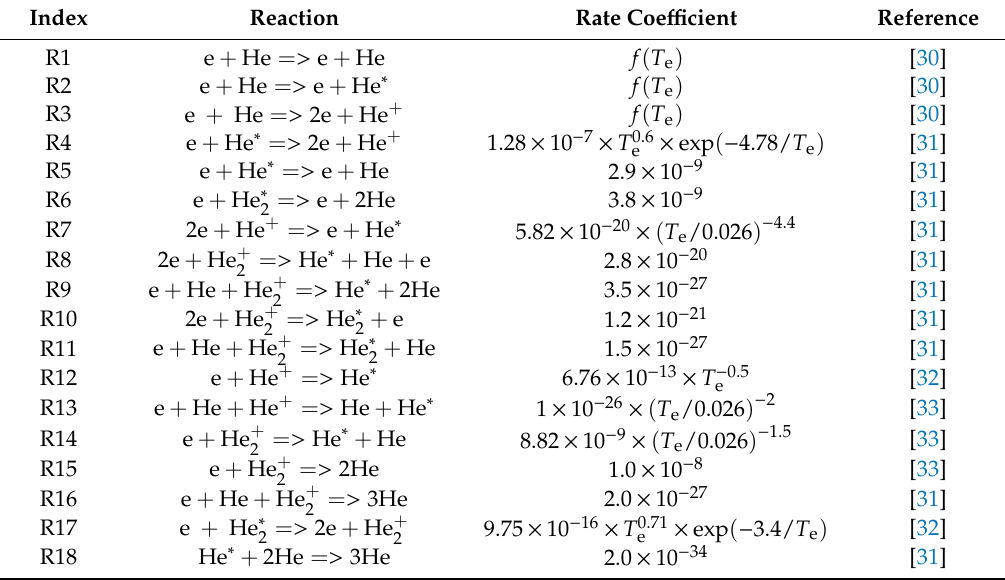
Table A1. Chemical reactions considered in the